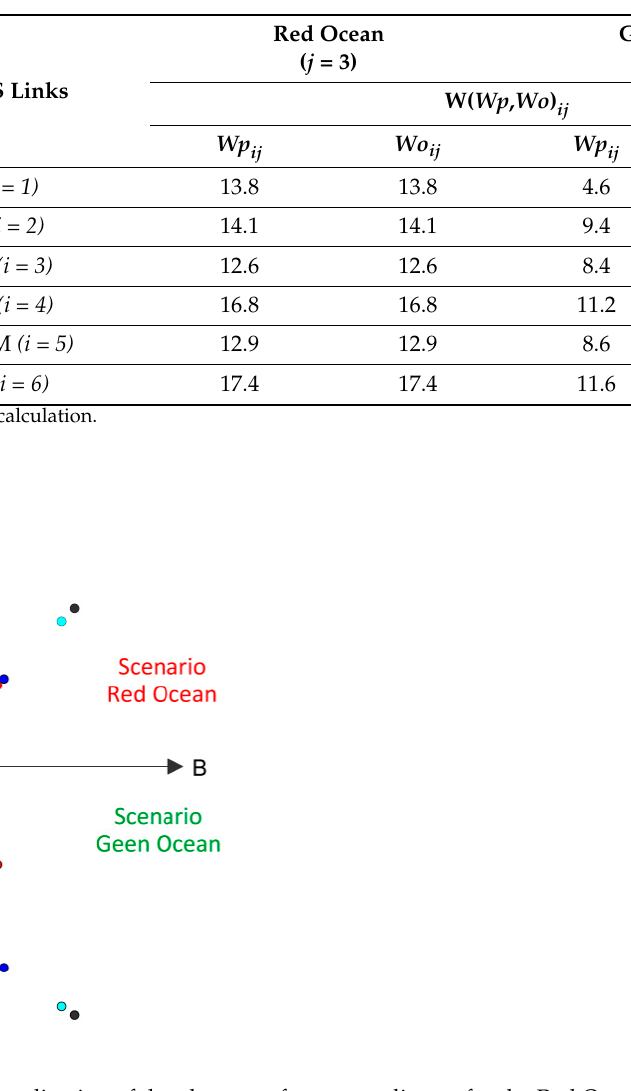
Table 5. PES development path—coordinates of development factors for the Red Ocean and the Green Ocean.